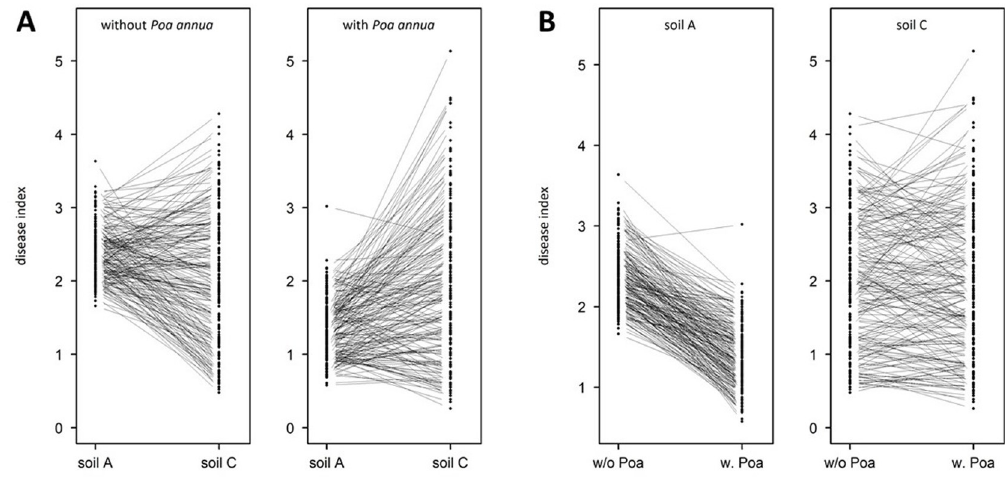
Fig 2. Extensive Genotype x Environment (GxE) interactions across the micro-habitats. (A) GxE interactions between soil A and soil C in absence (left panel) and presence (right panel) of P . annua . (B) GxE interactions between the absence and presence of P . annua on soils A (left panel) and C (right panel). Each dot corresponds to the Best Linear Unbiased Estimator (BLUE) for disease index of one of the 195 accessions. Each line connects one of the 195 accessions between two micro-